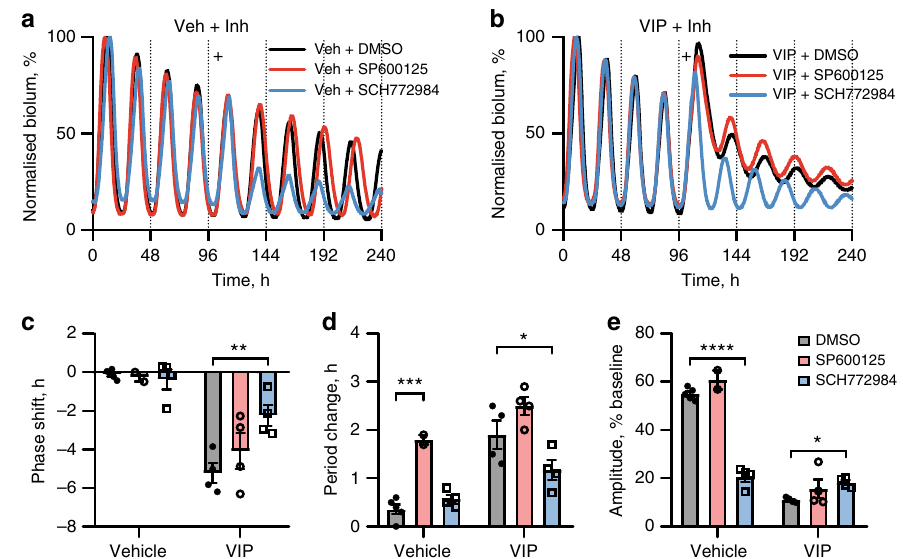
Fig. 5 ERK1/2 activation is essential for the VIP response. a , b Representative PER2::LUC bioluminescence rhythms of SCN slices treated with vehicle ( a ) or 1 µ M VIP (( b ) marked by plus) at CT10, 30 min after 3 µ M SP600125 (JNK1/2/3 inhibitor), 100 nM SCH772984 (ERK1/2 inhibitor) or vehicle. Bioluminescence has been normalised to the fi rst peak. c – e Group data for phase shift ( c ), period change ( d ) and amplitude ( e ) responses after treatments (mean ± SEM; Veh/Veh ( n = 5), Veh/VIP ( n = 4), SP600/Veh ( n = 3), SP600/VIP ( n = 4), SCH772/Veh ( n = 4), SCH772/VIP ( n = 4); two-way ANOVA with Dunnett ’ s multiple comparisons test, * P < 0.05, ** P < 0.01, *** P <